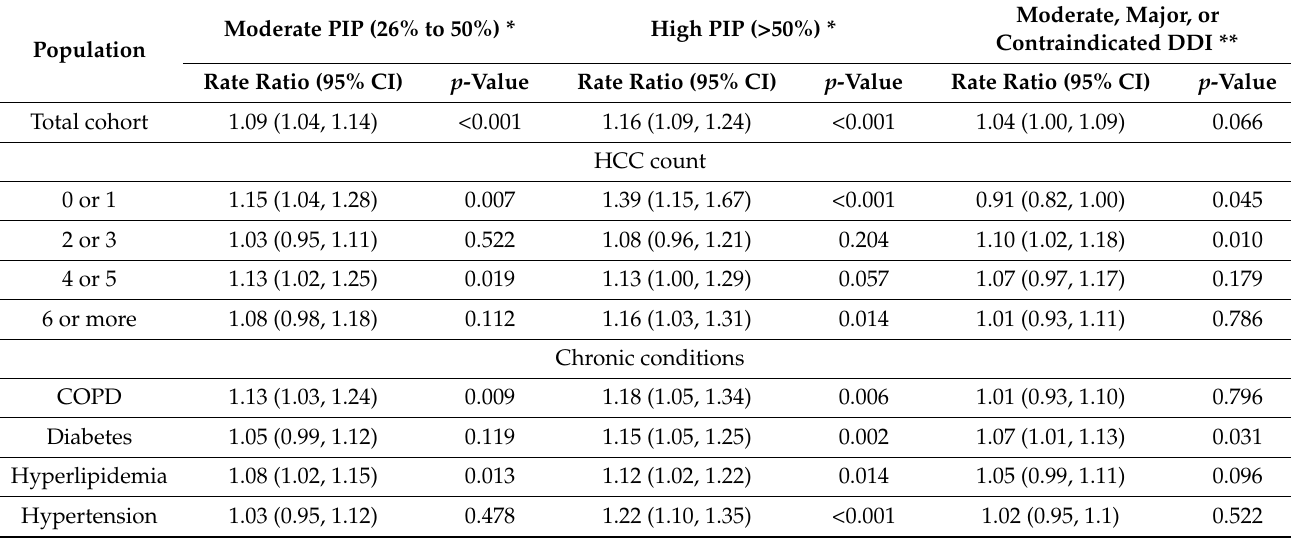
Table 2. Expected length-of-stay ratios by pharmacogenetic risk and drug–drug interactions among patients by HCC count and chronic conditions based on regression models.